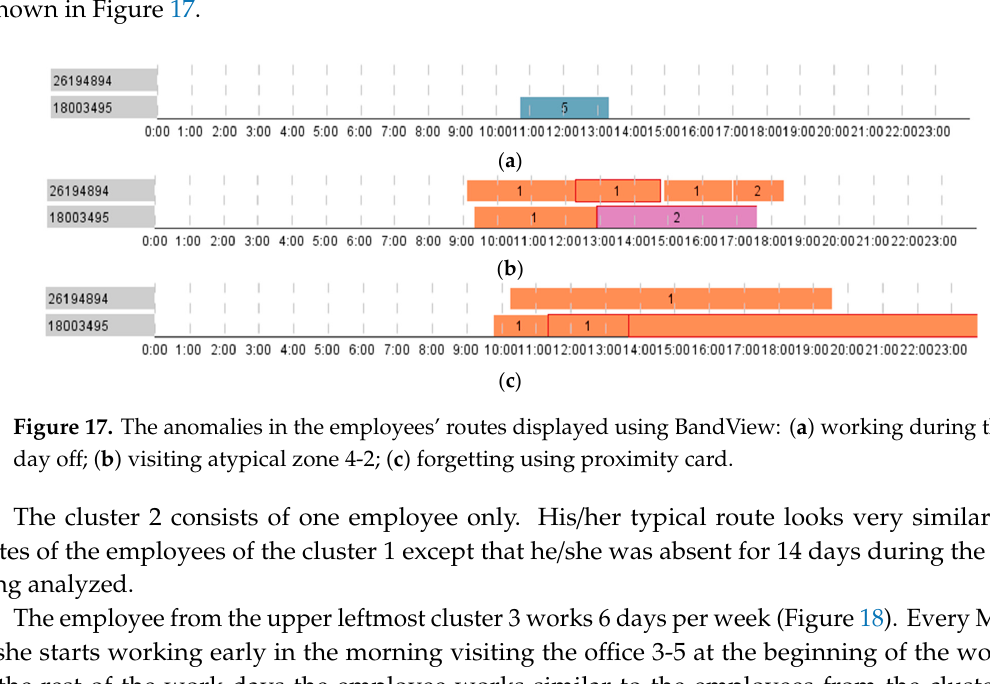
Figure 16. ( a ) The typical routes of the IT employees and ( b ) the heat map of anomalies in their routes.